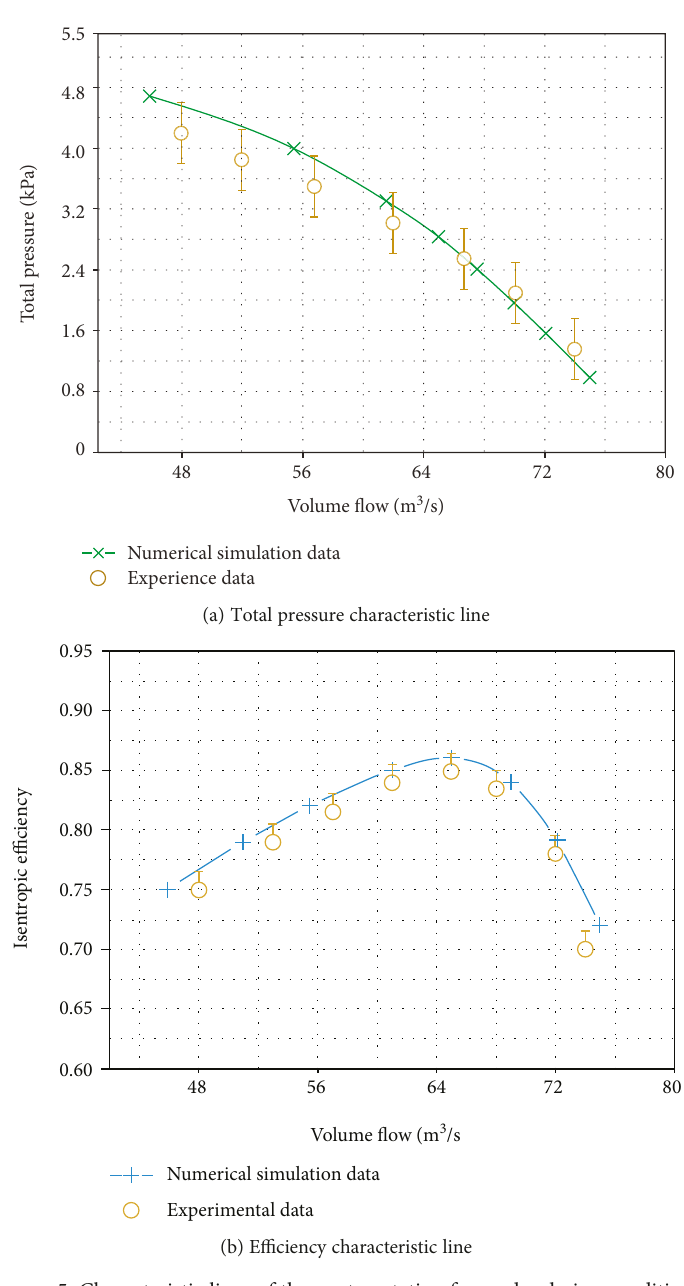
Figure 5: Characteristic lines of the contrarotating fan under design